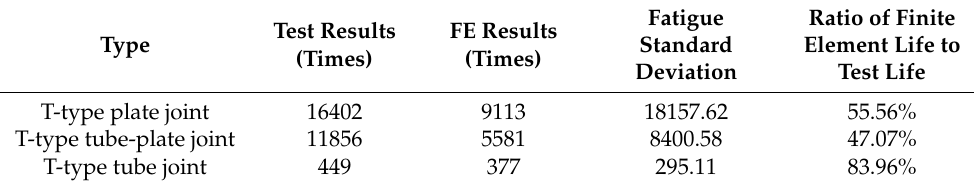
Table 11. Comparison between the outputs of the fatigue tests and finite element analysis method. Test Results FE Results Type (Times)